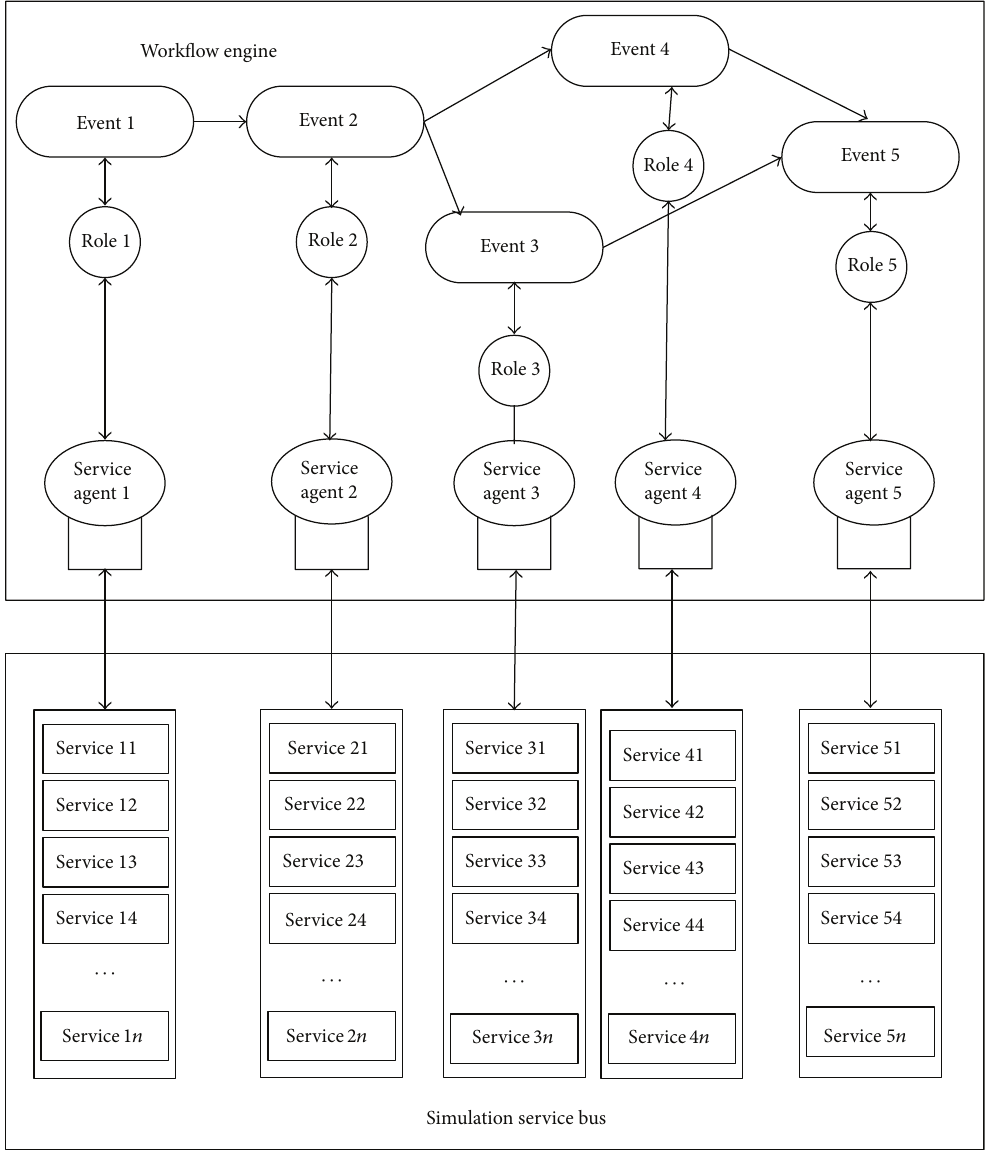
Figure 1: Simulation task workflow running framework.